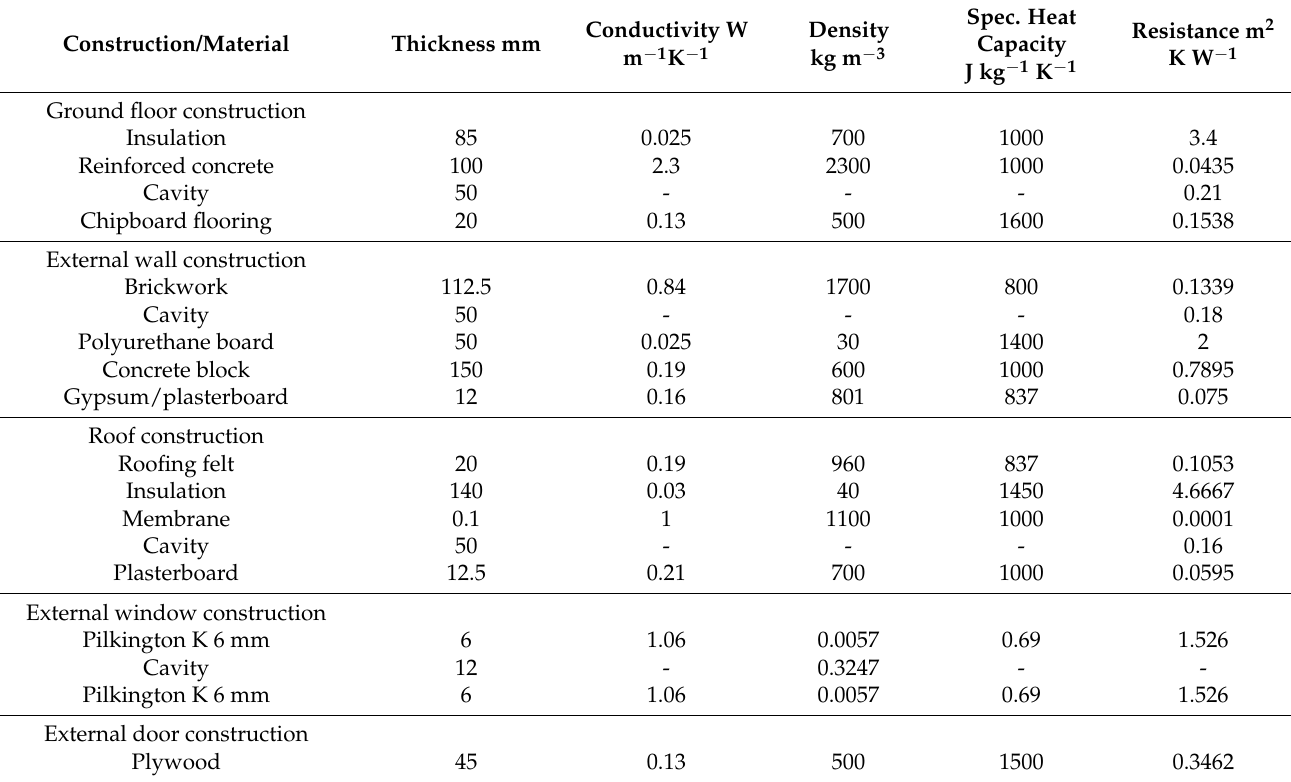
Table 6. Details of